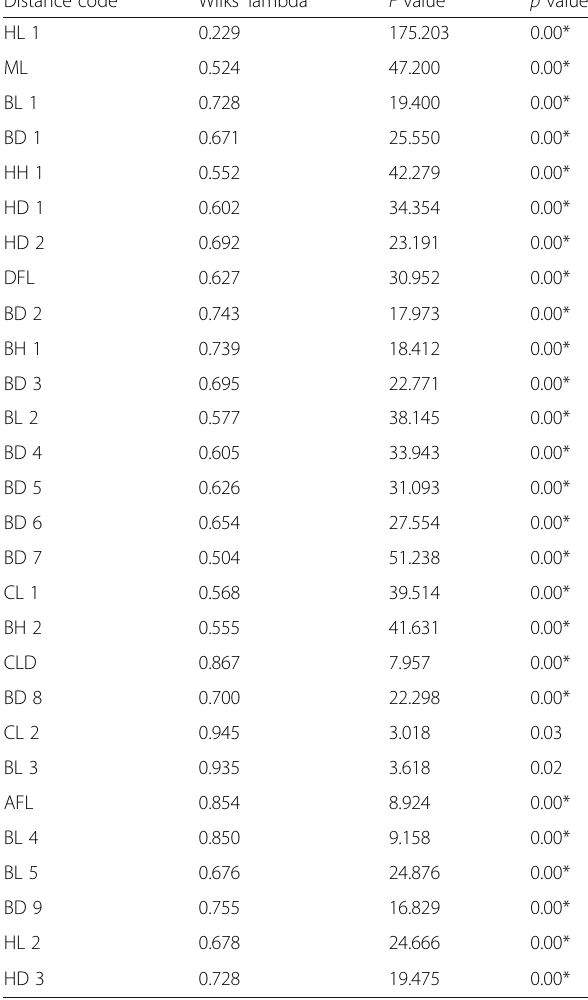
Table 4 ANOVA of morphometric characters for A. clupeoides samples collected from the Bay of Bengal coast, Bangladesh Distance